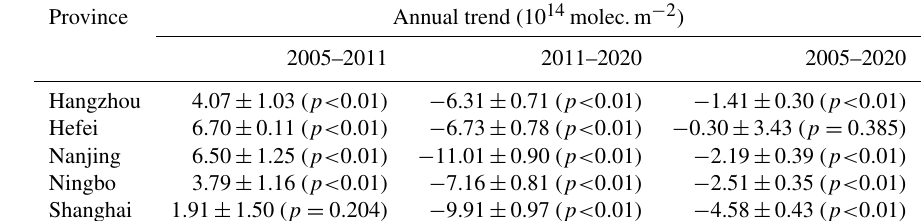
Table 4. Inter-annual trends of NO 2 VCD trop over each city within the YRD during 2005–2011, 2011–2020, and 2005–2020.